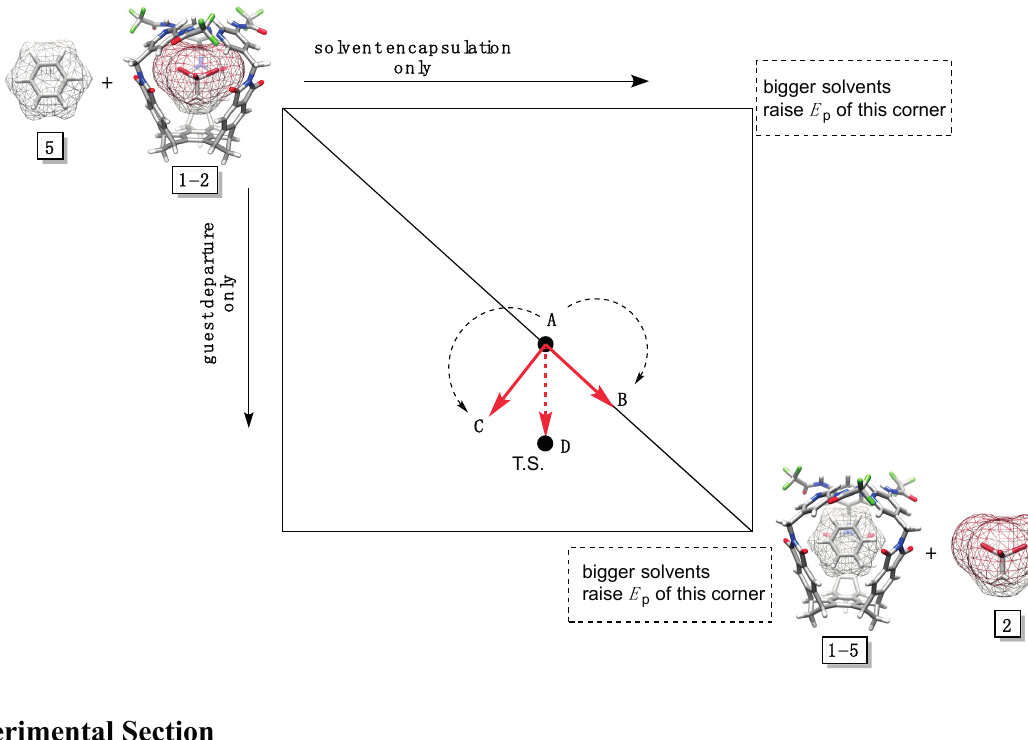
Figure 5. A More O’Ferrall-Jencks plot for solvents 3 – 6 (only 5 is shown) displacing 1,1,1-tribromoethane 2 in basket 1